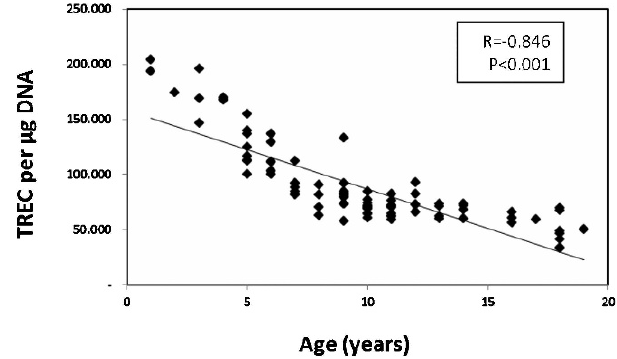
Figure 1 - Distribution of TREC levels per m g of DNA among healthy children and adolescents from 1 to 18 years of age. TREC levels per m g of DNA showed a strong inverse correlation with age (r=Spearman’s correlation